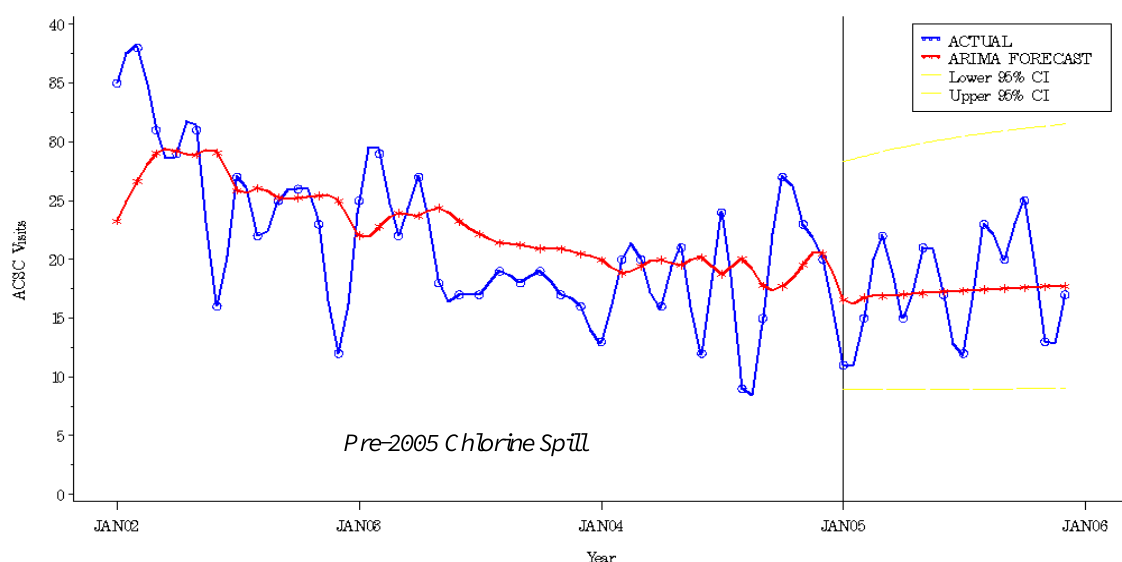
Figure 2. Model Actual vs. Predicted Plot of Ambulatory Care Sensitive Conditions ± with 95% Confidence Band for Control and Control Group: SC Medicaid Beneficiaries, 2002 –